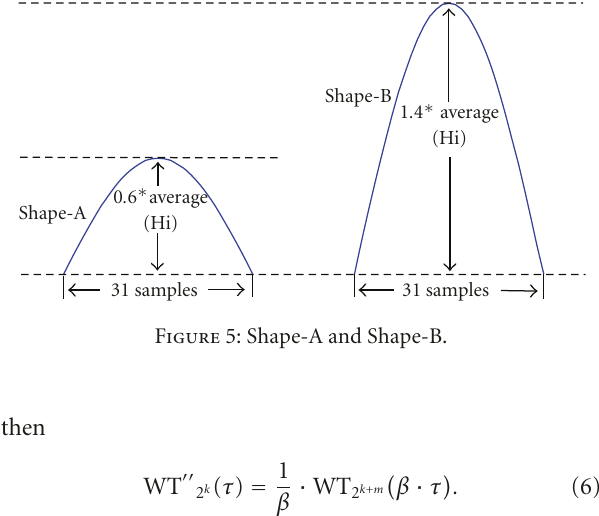
Figure 5: Shape-A and